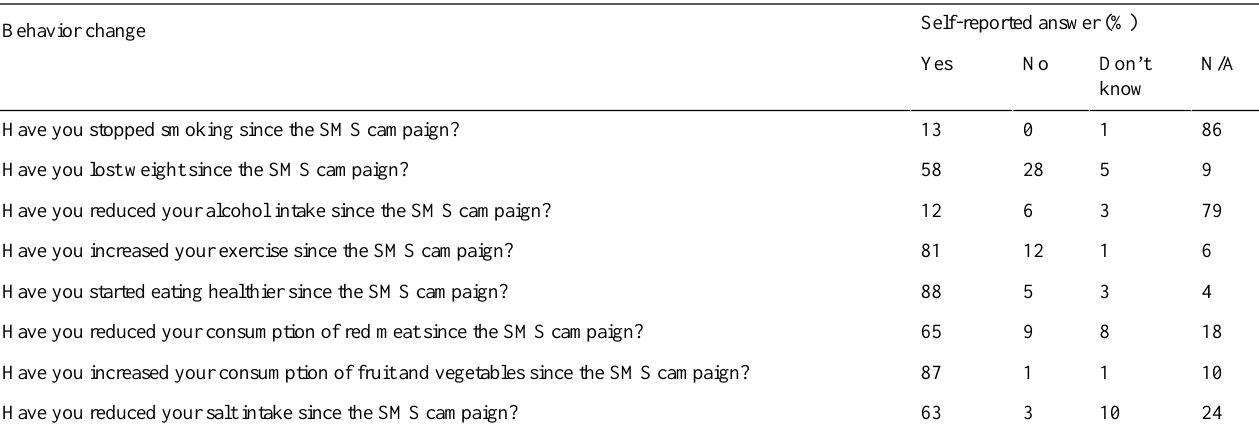
Table 3. Self-reported behavior changes for intervention